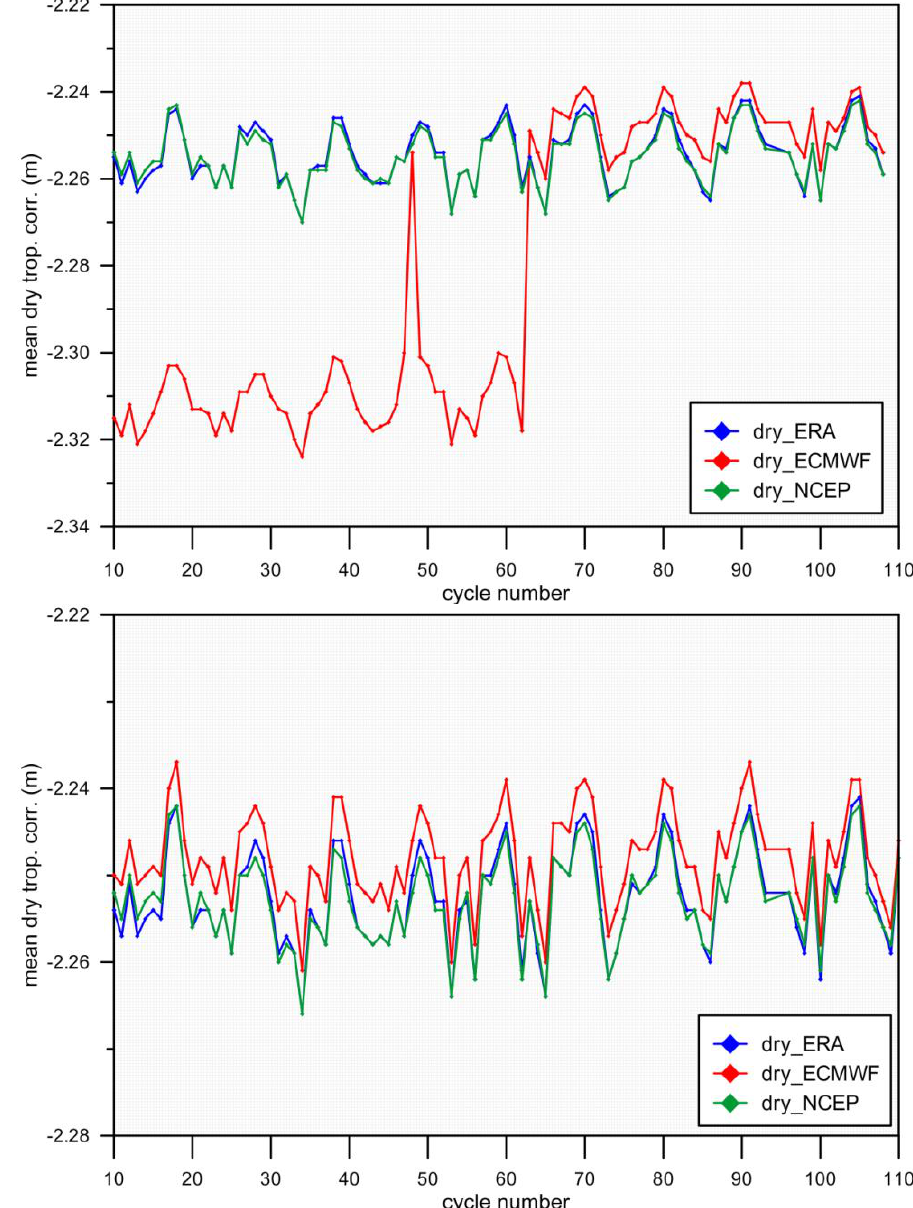
Figure 6. The same as in Figure 5, for Envisat Cycles 10 to 93 for GDR data version 1 ( top ) and version 2.1 ( bottom ). Cycles 1 to 9 are not shown, since Cycles 1 to 5 are not available in RADS and Cycles 6 to 9 contain a small number of